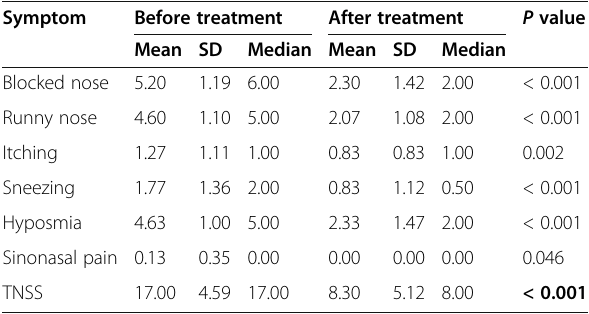
Table 5 Total nasal symptoms score (TNSS) before and after treatment in the oral steroid group Symptom Before treatment After treatment